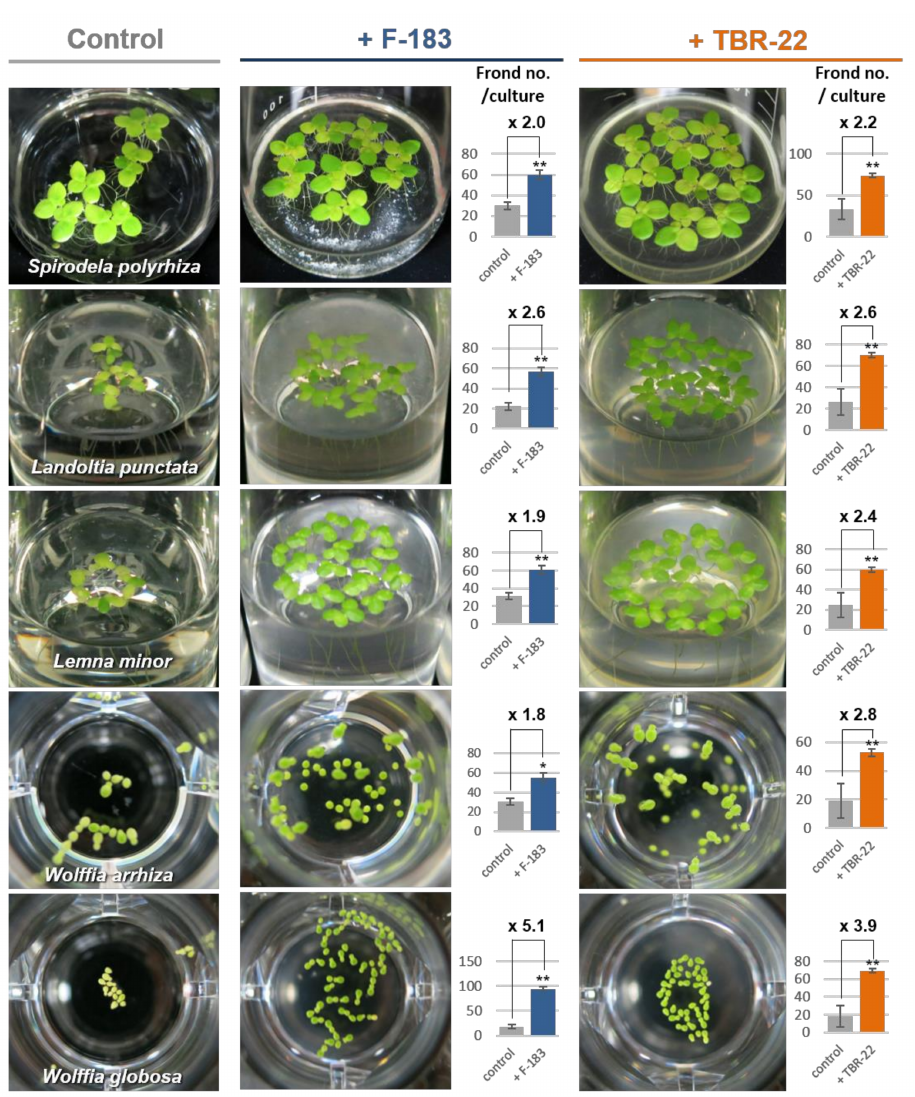
Figure 3. Plant growth promotion effects of the Acidobacteria strains F-183 and TBR-22 on duckweed members of the subfamily Lemnoideae . Images were taken at day 14 in independent experiments from the quantitative growth promotion assays represented by the bar plots. Frond number was manually counted at day 14 (see Methods). n = 3; **, p < 0.01; *, p < 0.05; bars,